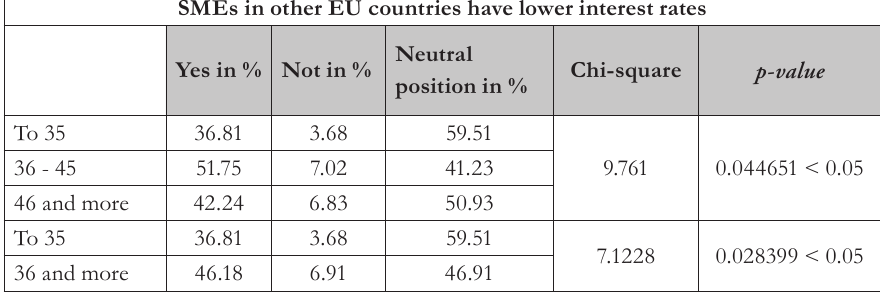
Table 6 Comparison of Pearson chi-square calculations among the chosen age groups in rela - tion to the interest rate risk SMEs in other EU countries have lower interest